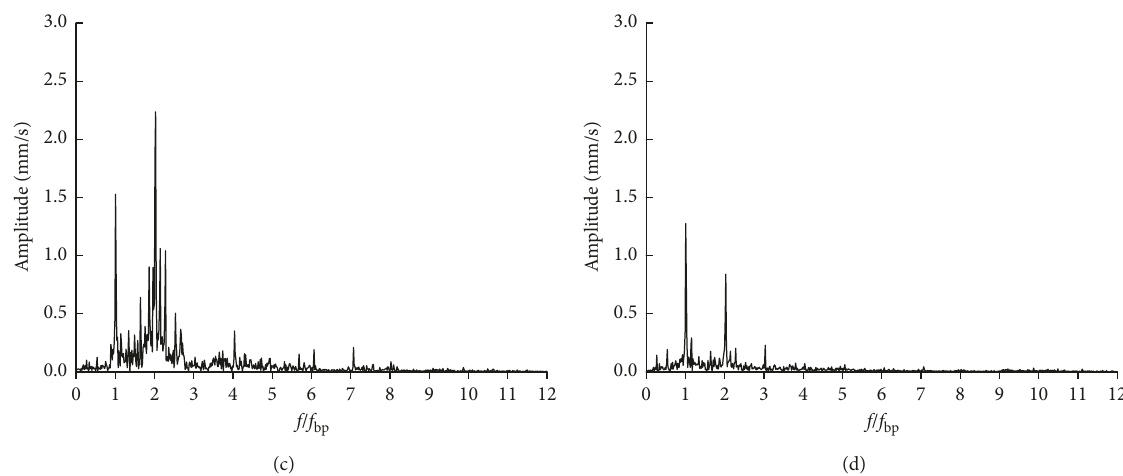
Figure 7: Vibration spectrum at the design flow rate: (a) CH3; (b) CH4; (c) CH5; (d) CH6.